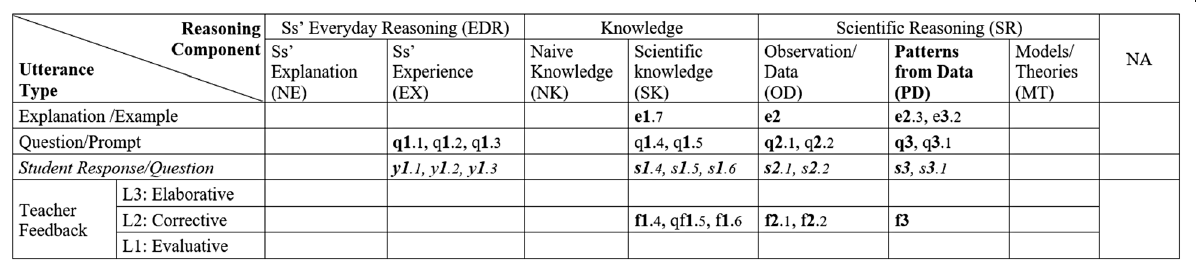
Fig. 4 Ann ’ s CDAT table coded and the dialogs. At a glance, it shows what reasoning components the teacher used in the dialogs, i.e., EX, SK, OD, and PD. It also shows how the dialogs flow. It starts with a question about student experience (q1.1) and ends with an explanation (e3.2)